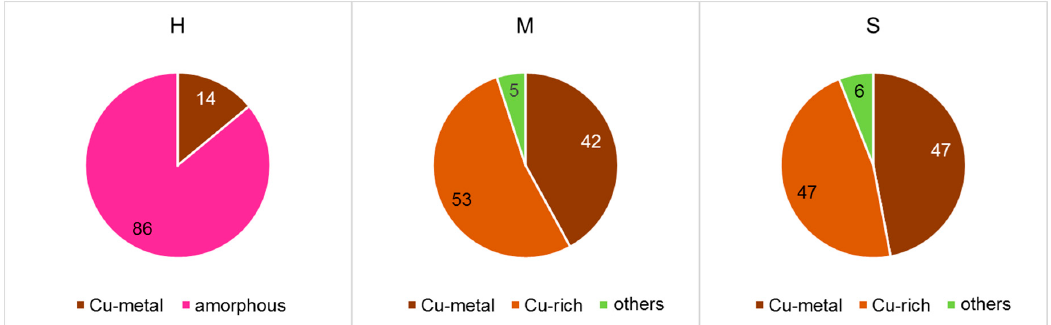
Figure 15. Deportment of Cu as a percentage in the three different samples (H, M, and S) between the different main phases: Cu-metal, Cu-rich, and amorphous.